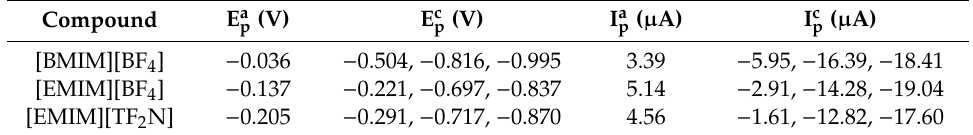
Table 2. Cathodic and anodic peak potential and peak current for 2,6 DNT obtained from Figure 2a.